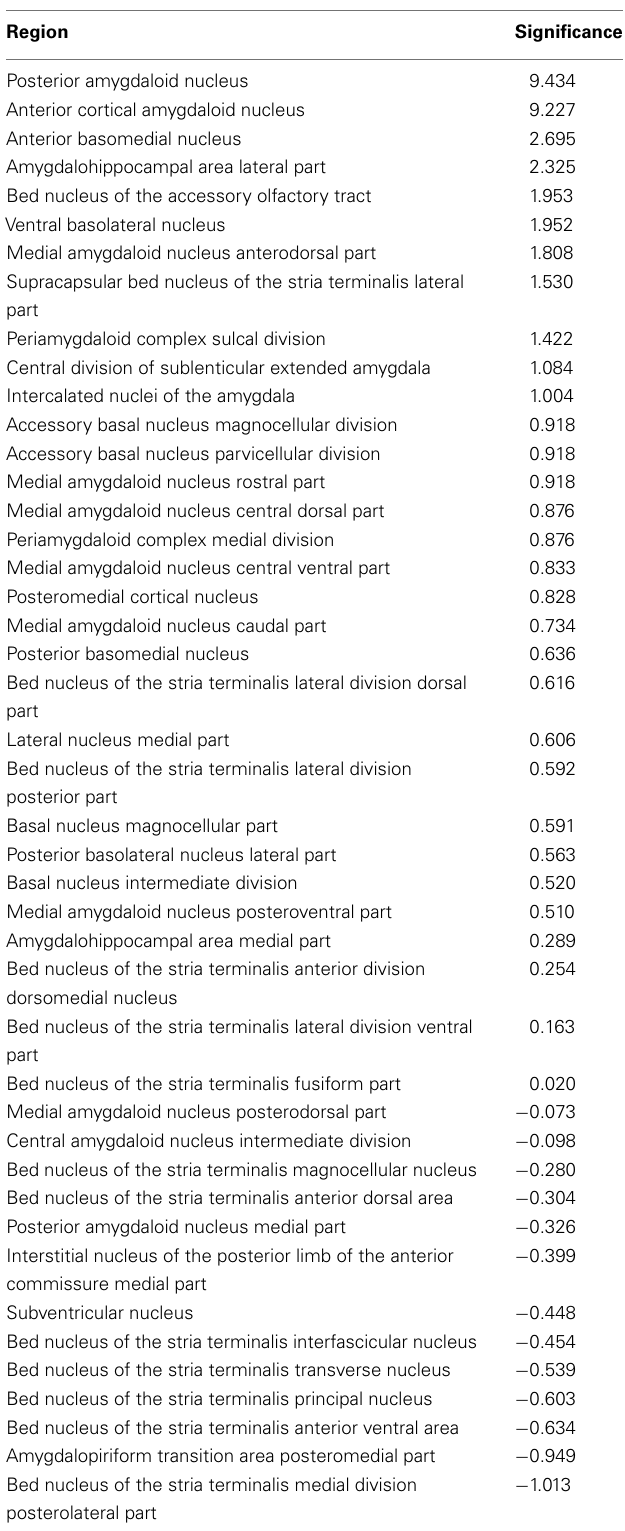
Table 6 | Significance of regions in percent based on the change of closeness after removing a particular region from the